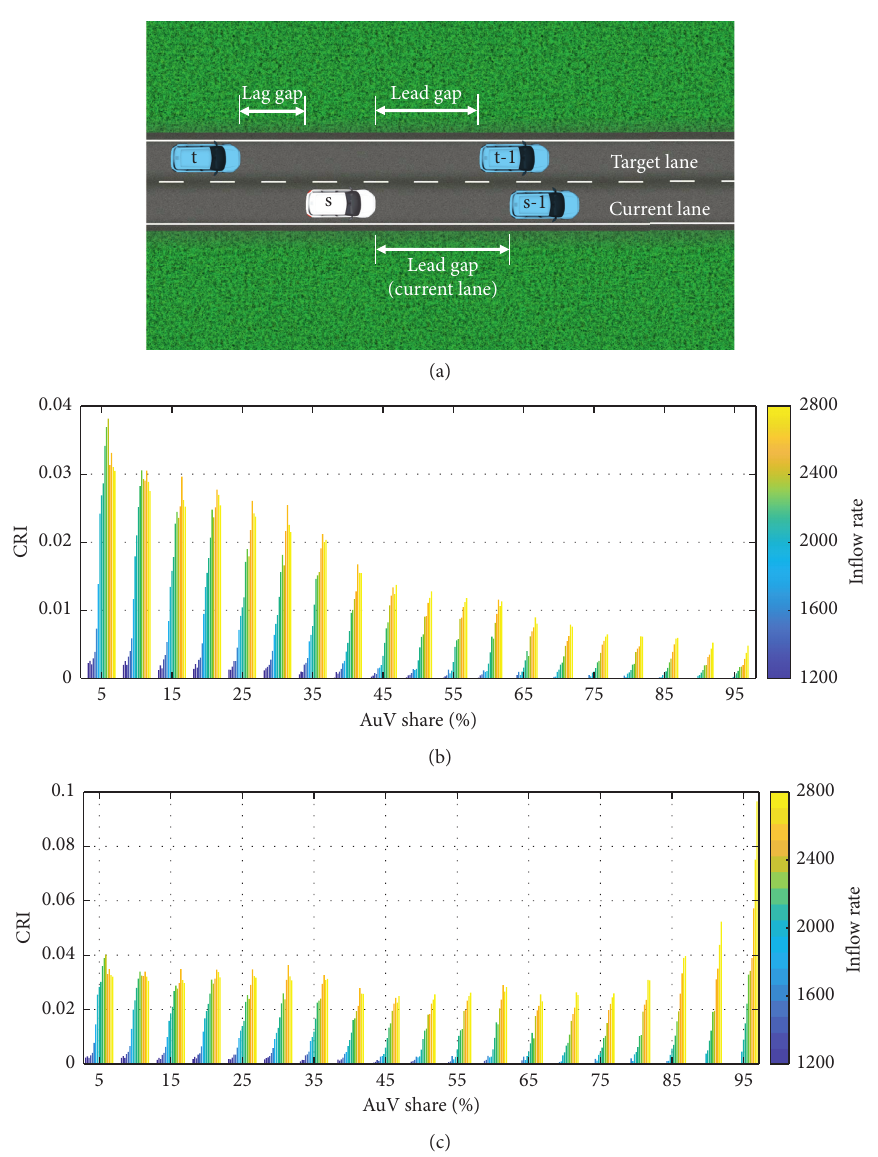
Figure 6: (a) Subject vehicle’s perspective of decision parameters, and CRI values for simulated traffic states considering (b) all vehicles and (c) HuVs